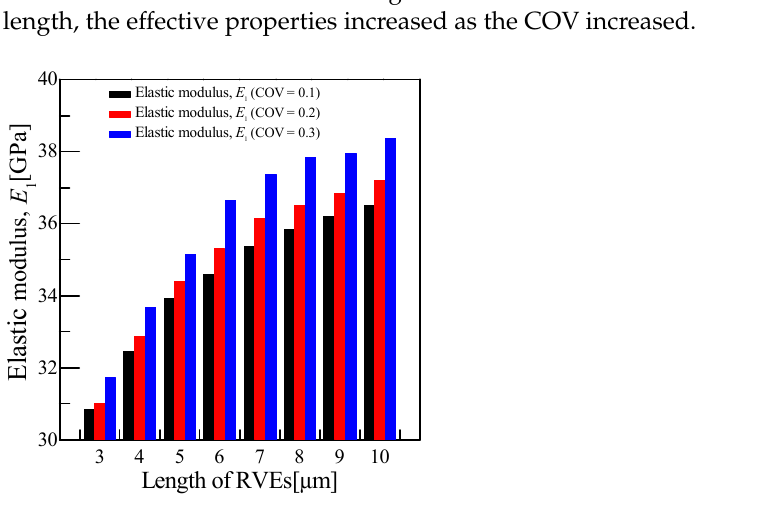
Figure 12. Changes in the effective properties according to changes in the RVE length and COV.